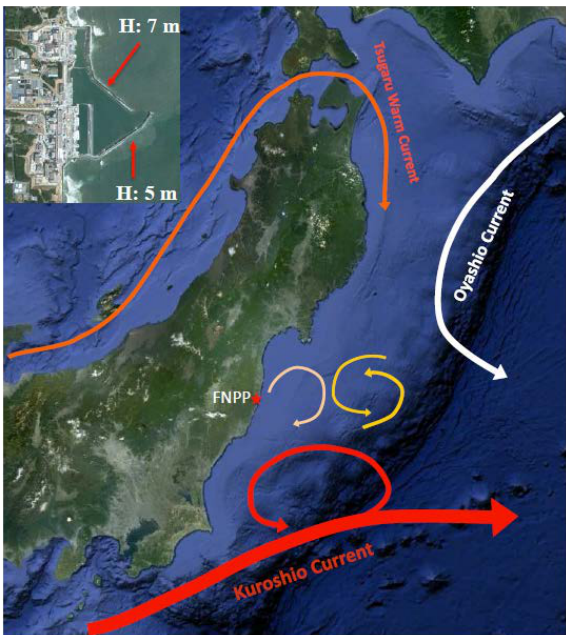
Fig. 1. Schematic of the regional circulation pattern with an en- larged view of the Fukushima Dai-ichi Nuclear Power Plant.